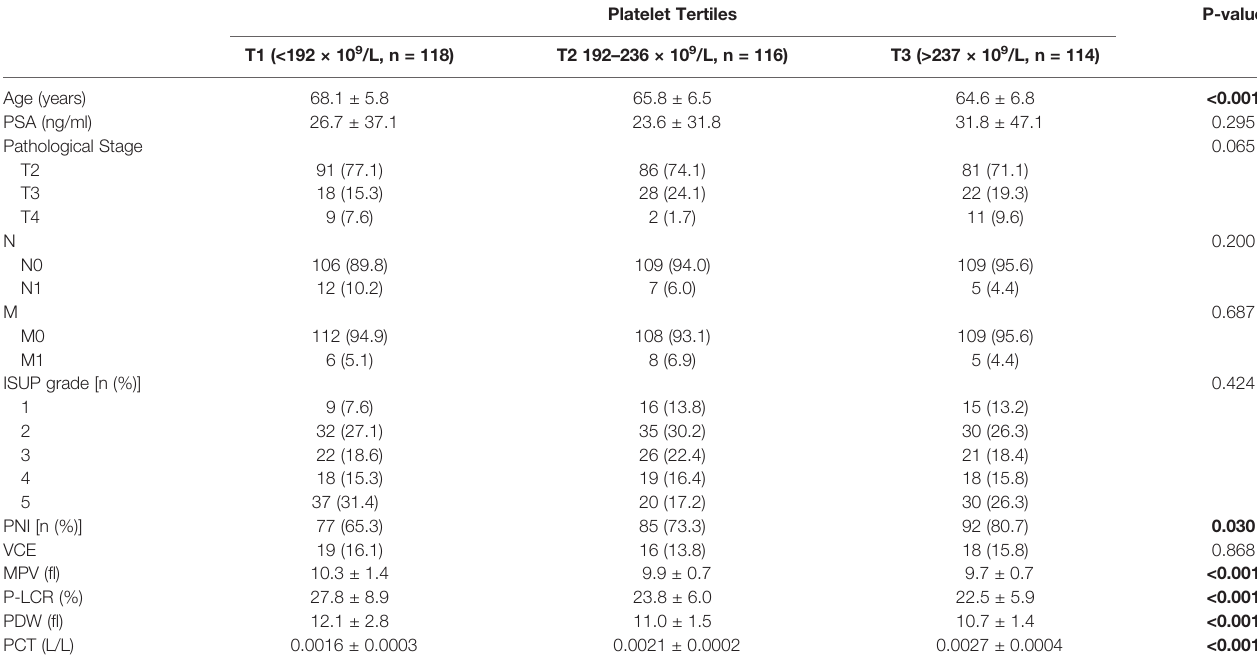
TABLE 2 | Clinical characteristics of PCa subjects according to tertiles of platelet levels.